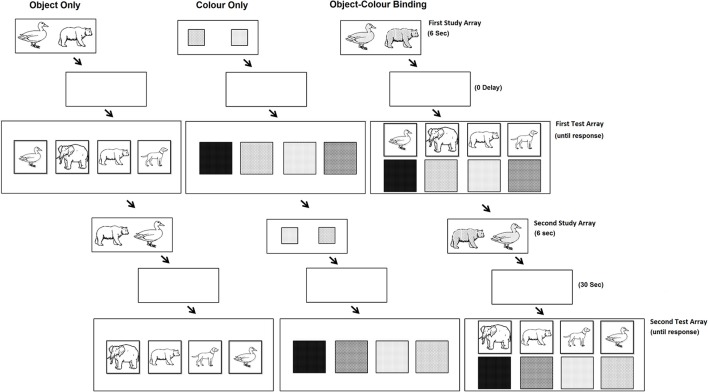
The experimental conditions and trial sequences used in our experiment (see text for description).